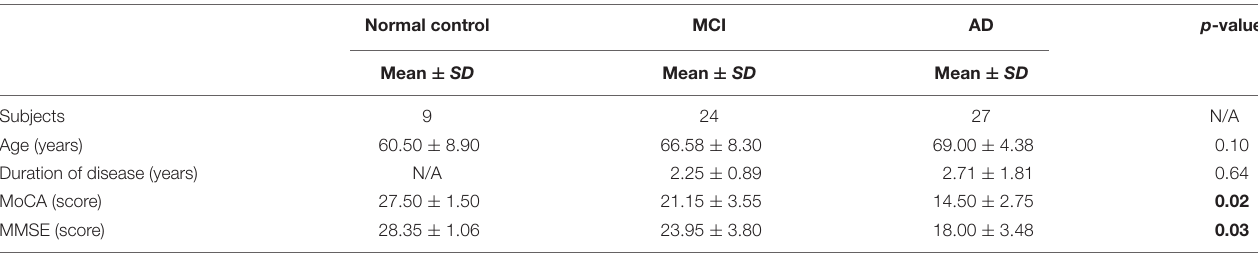
TABLE 1 | Clinical characteristics of study